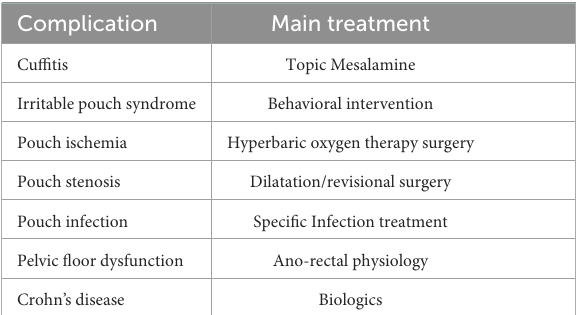
TABLE 1 Differential diagnosis complications in patients with UC after total proctocolectomy with IPAA different from pouchitis and their